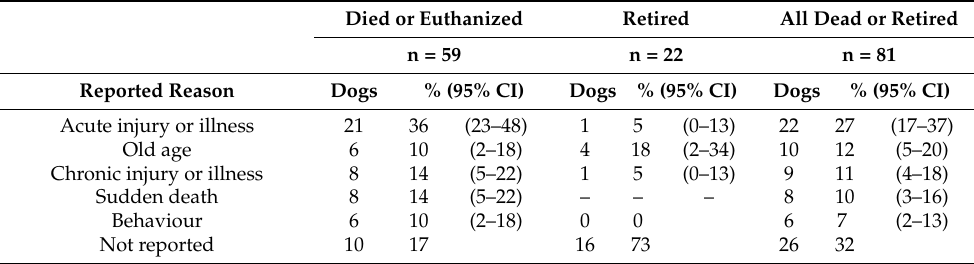
Table 4. Owner-reported reasons for death or retirement of 81 dogs enrolled in TeamMate.